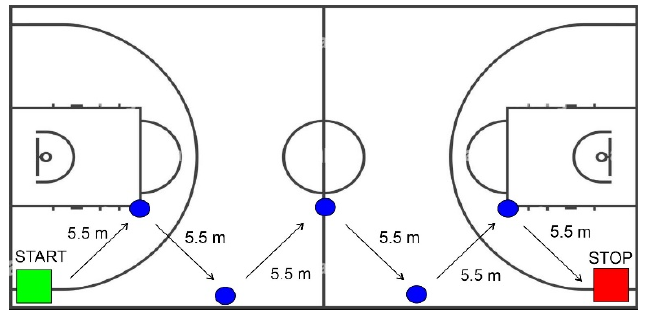
Figure 3. Representation on the path used in the basketball tests. For each task the test completion time was recorded and expressed in